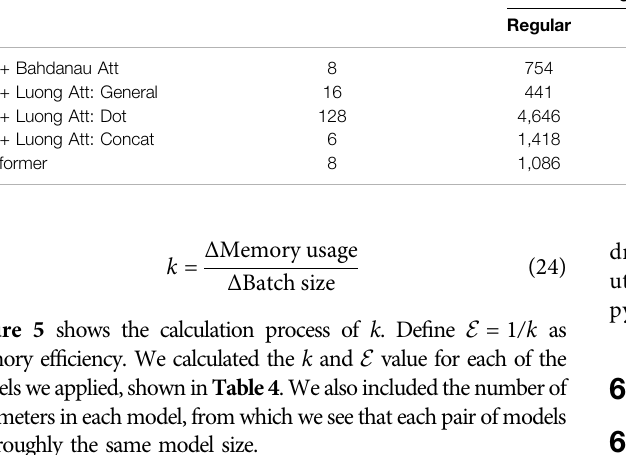
TABLE 3 | Training speed of GRU and Transformer on Juliet Test Suite for C/C++.